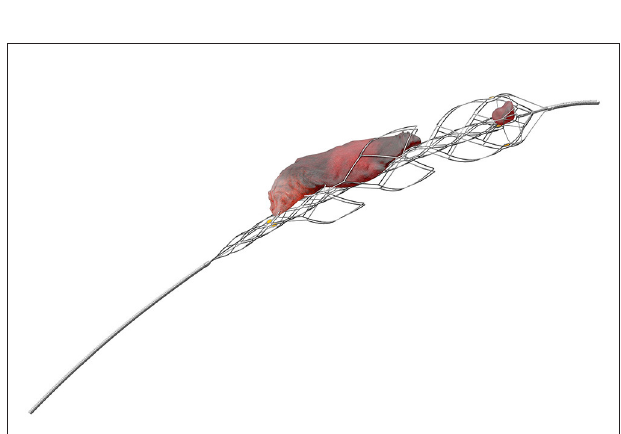
FIGURE 4 | EmboTrap reperfusion device (third-generation stent retriever) from Cerenovus (Miami, FL, USA).